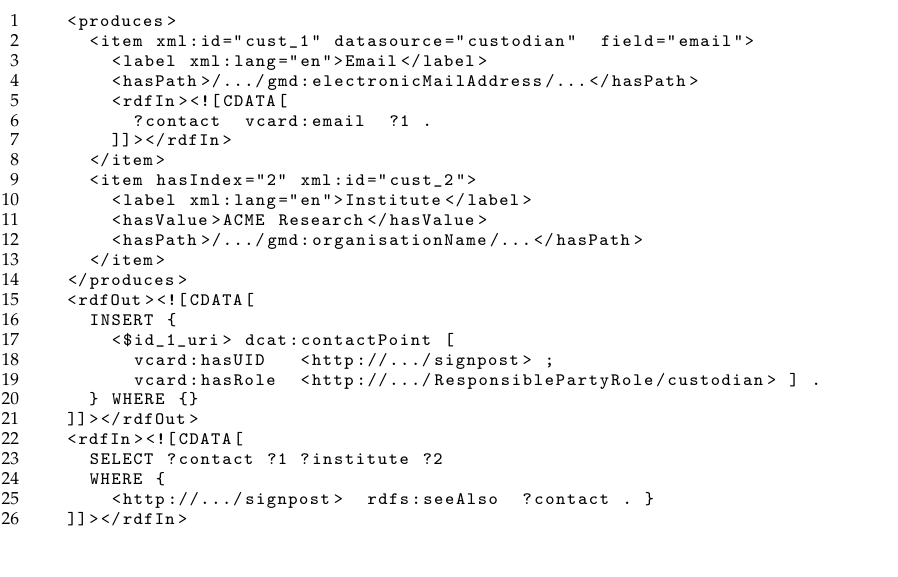
Listing 5. Template definitions implementing